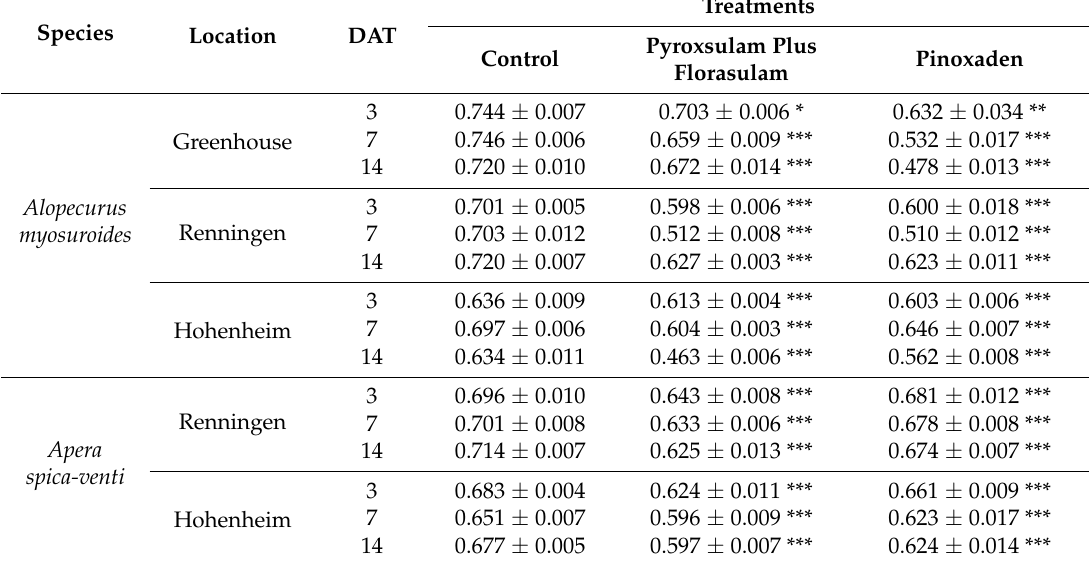
Table 2. Average value of F v / F m of Alopecurus myosuroides , Apera spica-venti and the Tukey’s HSD test results of treated and untreated plants. Significant codes due to p values: 0 ‘***’ 0.001 ‘**’ 0.01 ‘*’ 0.05